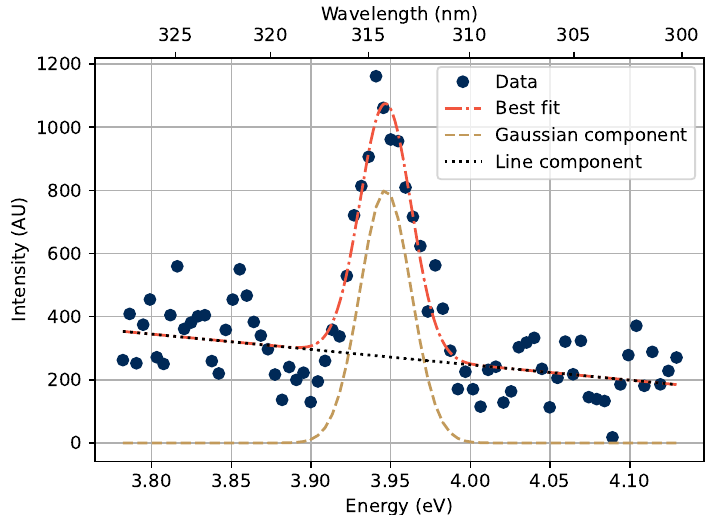
Figure 5. The wavelength region with the 314 nm emission peak from the Gd 3 + -ions as measured under 4 cm acrylic and 12 MeV electrons. The emission peak was approximated as a Gaussian over the Cherenkov radiation background, which in turn was approximated with a straight line in the region shown in the